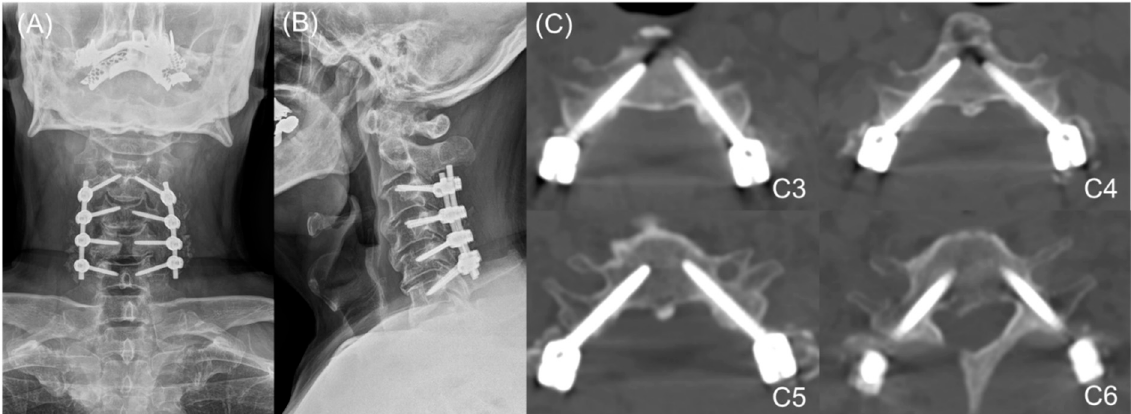
Figure 4. Cervical spine radiographs and computed tomography (CT) of screw insertion ( A ) Cervical spine anteroposterior radiography, ( B ) Cervical spine lateral radiography, and ( C ) Cervical spine axial images of CT scan.